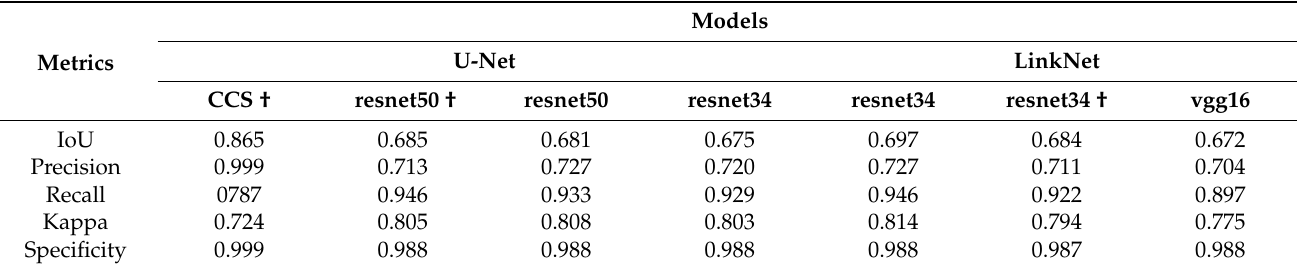
Table 1. Result of the metrics for the U-Net and LinkNet models, and the different network architectures. The weights of a pre-trained network with ImageNet are used to initialize each of the models.